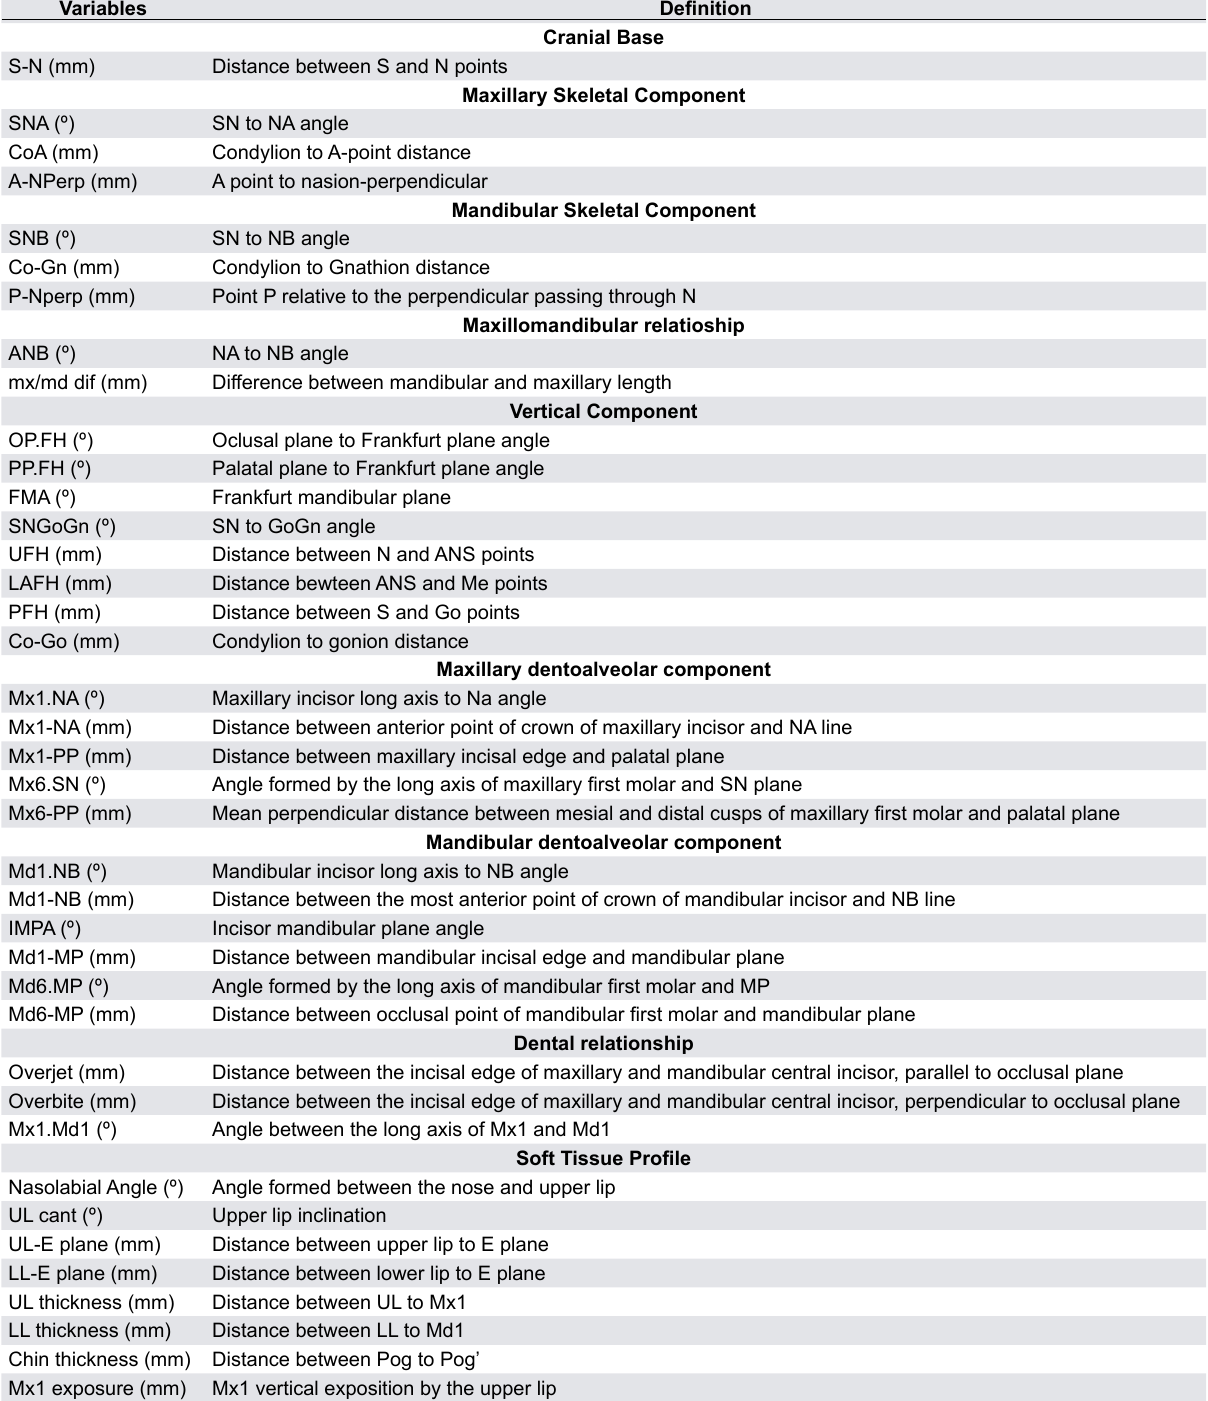
Table 1- Skeletal, dental, soft tissue profile cephalometric